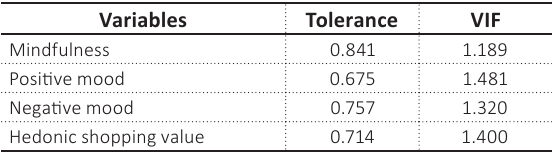
Table 2. Multicollinearity results of variables